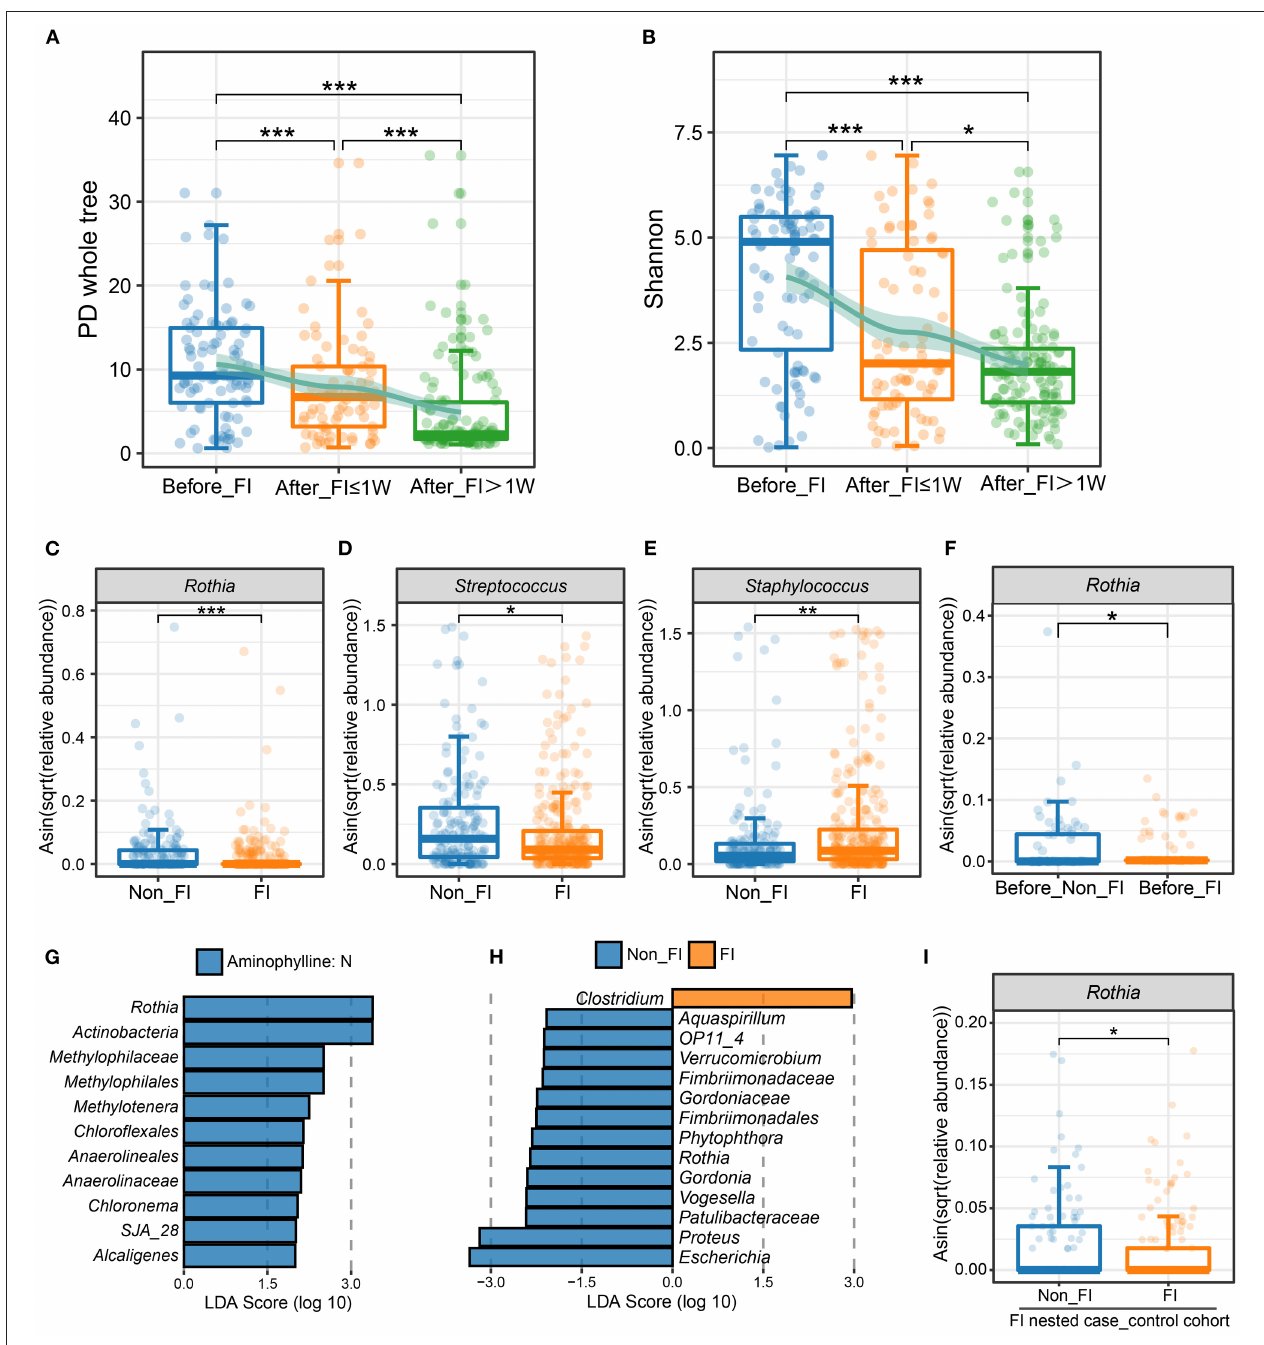
FIGURE 5 | Differences in the microbiome between patients with FI and without FI. (A,B) Comparison of the PD whole-tree index (A) and Shannon index (B) among different FI stage groups. The jittered scatter plot represents the α -diversity index of each sample. The curves on the top layers of the graphs were fitted with the LOESS method. *, FDR < 0.05; **, FDR < 0.01; ***, FDR < 0.001. (C – E) Boxplots and jittered points show the abundance distribution of Rothia (C) , Streptococcus (D) and Staphylococcus (E) between the non-FI and FI groups. Each point represents a sample. *, P < 0.05; **, P < 0.01; ***: P < 0.001. (F) Boxplot and jittered points show the abundance distribution of Rothia between the before-FI (samples before the FI onset) and before-non-FI (samples before 6 days age) groups. Each point represents a sample. *, P < 0.05. (G) Significantly differentially abundant bacterial taxa between FI patients with and without aminophylline, estimated by LEfSe. Each bar represents the LDA score for a specific taxon. The color of a bar indicates that the taxon was enriched in the corresponding group. (H) Significantly different bacterial taxa between the non-FI and FI groups among patients treated with aminophylline. (I) Comparison of Rothia abundance between the non-FI and FI groups in the FI nested case-control cohort. *, P <